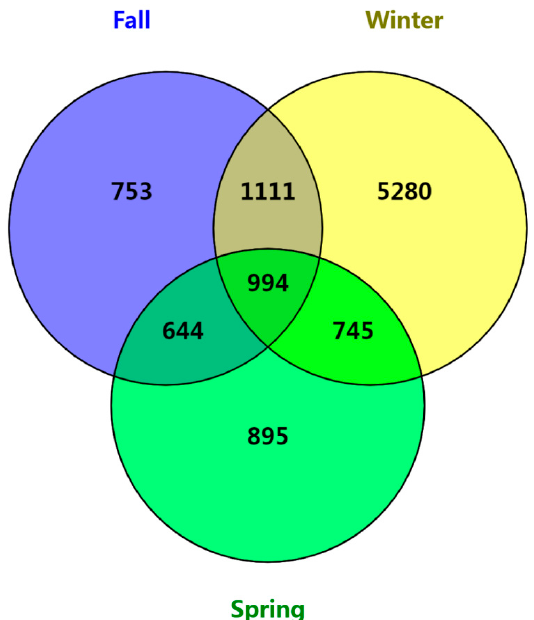
Figure 1. Venn diagram showing the unique and shared intestinal bacterial operational taxonomic units (OTUs) of hooded crane among the three seasons.